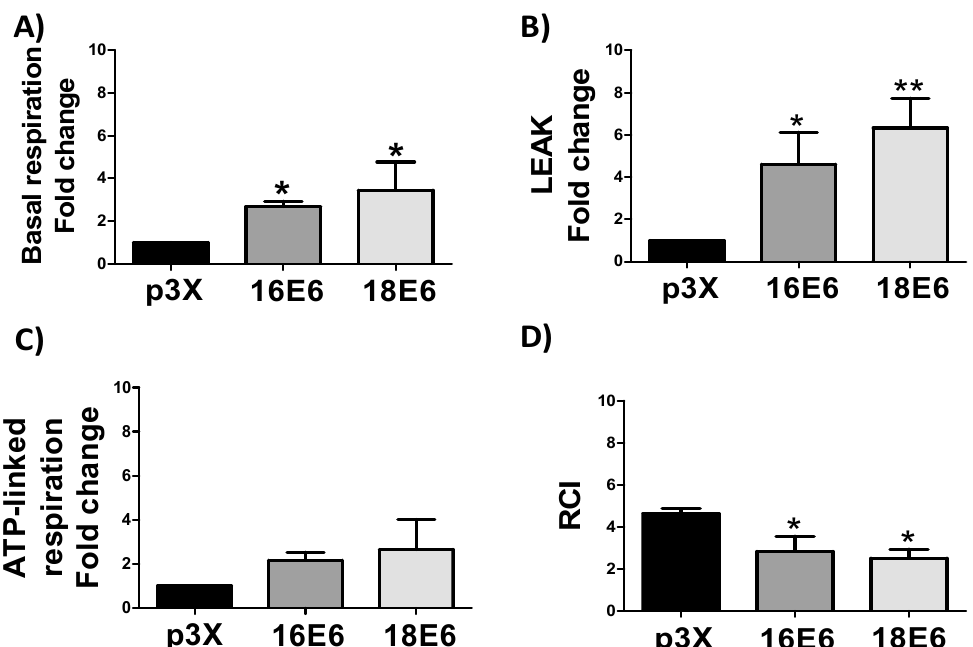
Figure 4. E6 oncoproteins from HPV16 and HPV18 promote cellular respiration and mitochondrial decoupling in FaDu cells. Mitochondrial respiratory parameters: ( A ) basal respiration, ( B ) leak, ( C ) ATP-linked respiration and ( D ) respiratory control index (RCI). Data are expressed as the mean ± SD. Tukey’s test * p < 0.05 and ** p < 0.005 vs. p3X control, n = 3.